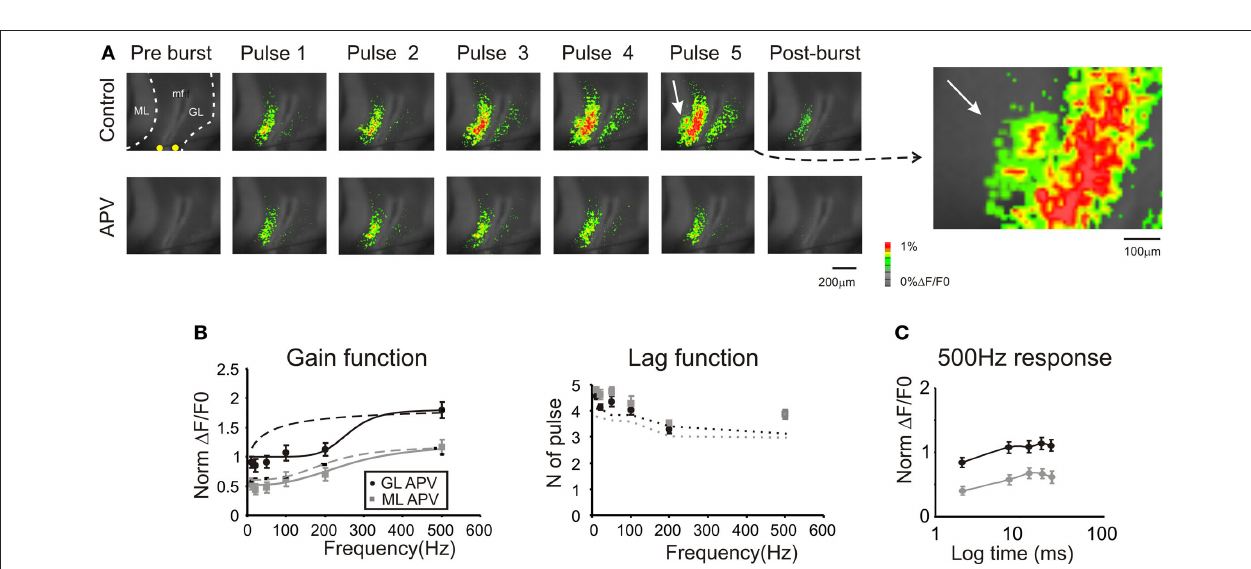
delivered at different frequencies both in the granular and molecular layer ( n = 4 slices, n = 16 ROIs for each frequency). Gain and lag curves for granular (black) and molecular layer (gray) responses show that gain increased and the shape of curves changed compared to control (dashed lines). The gain curves were fitted with a sigmoidal function (Eq.1). Lag remained over control values (dashed lines) at all frequencies. (C) The time course peak amplitude increase at 500 Hz, was taken to demonstrate for a representative frequency (the maximum tested) the non-saturating nature of the response in the presence of 10-μM gabazine (cfr Figure C ). Points are reported as mean ± SEM.